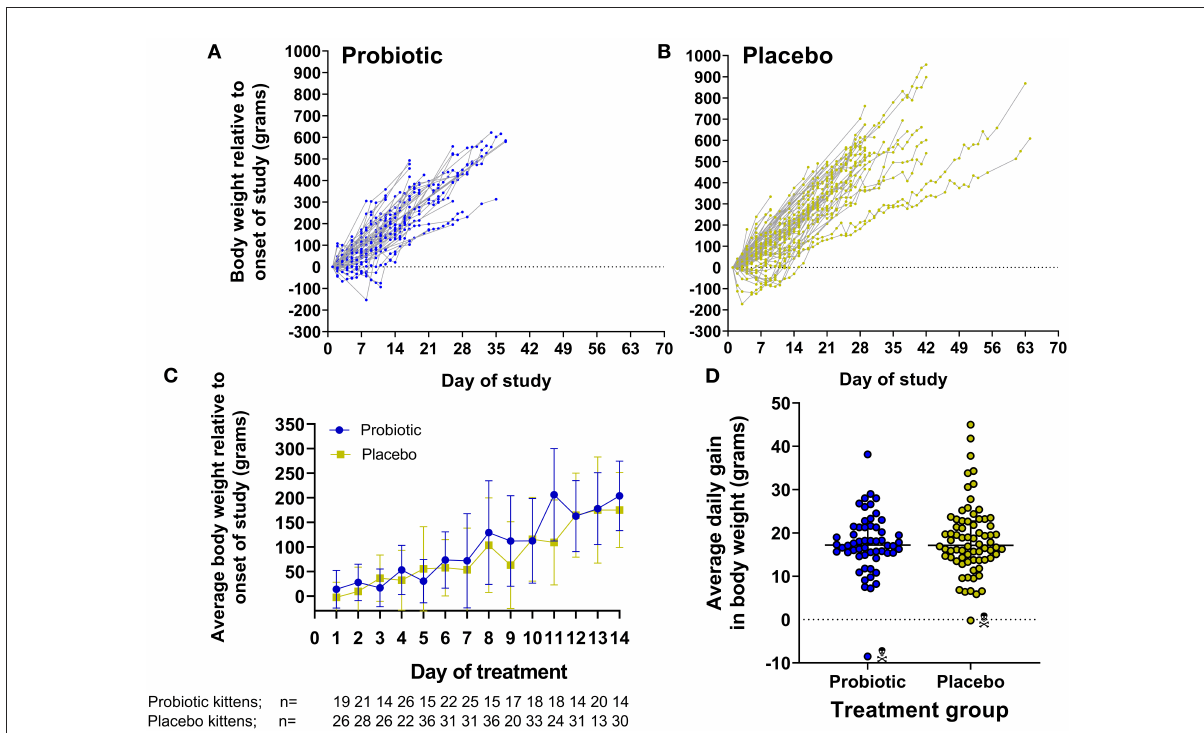
FIGURE2 Gain in body weight by kittens receiving probiotic or placebo. (A,B) Show daily gain in body weight normalized by initial body weight for individual kittens in each group over the course of the study. (C) Represents the average ± SD body weight of kittens comparing both groups on each day during the first 14 days of the study. Note that each time point represents only those kittens having their body weight measured on the given day which is indicated below the x-axis legend. (D) Demonstrates the average daily gain in body weight over the course of the study [(end weight – start weight)/number of days between weight measurements] in individual kittens comparing both groups. Kittens that died/where euthanized are designated by skull